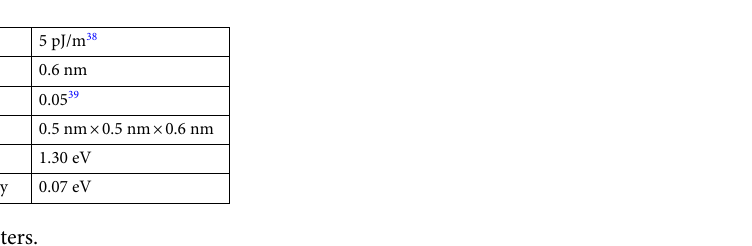
Table 1. List of